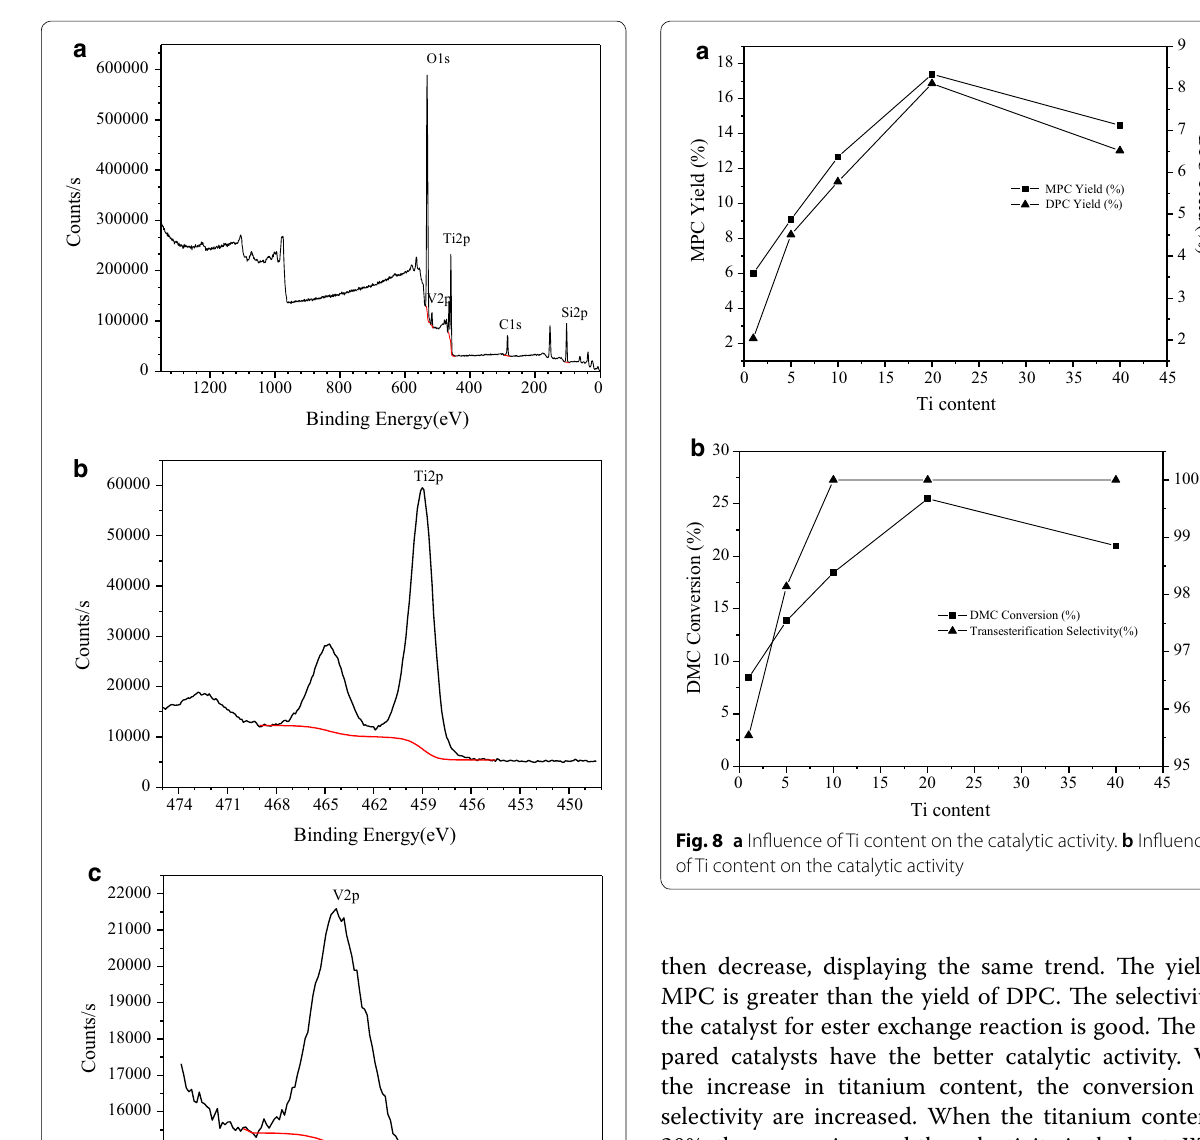
(8 h). The conversion rate of raw materials is low in the blank experiment, whereas the conversion and selectivity are improved obviously after adding the catalysts.